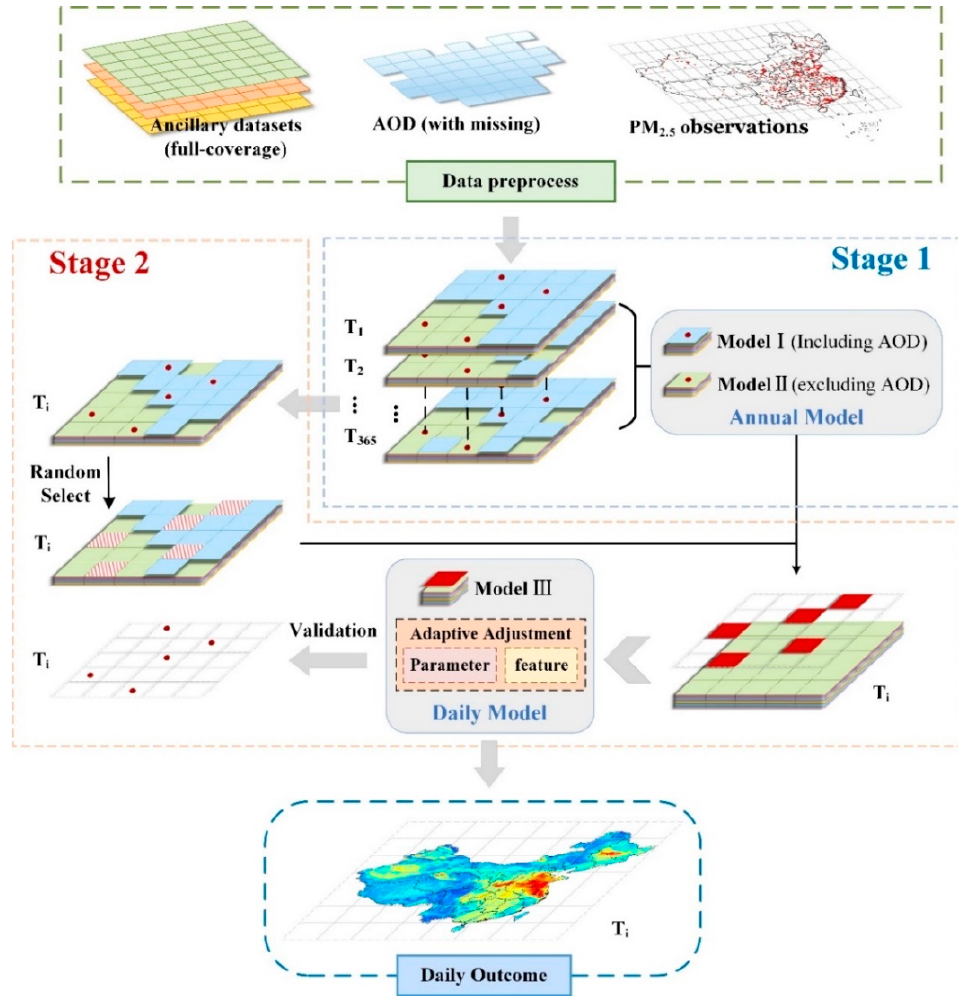
Figure 1. The framework of the proposed daily full-coverage PM 2.5 modeling scheme. The blue dashed box represents Stage 1 (annual modeling) and the outputs are the two annual models; the red dashed box represents Stage 2 (daily modeling) and the outputs are the estimated daily full-coverage PM 2.5 maps; T i represents the day of the year.